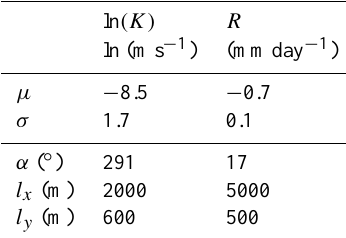
Table 2. Parameters and properties used for the generation of the synthetic conductivity and recharge fields ∗